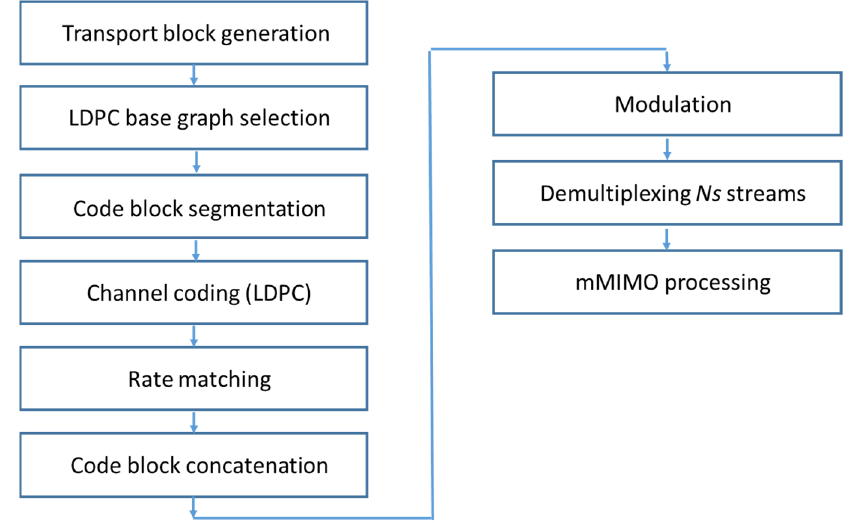
Figure 5. Block diagram of the physical layer.